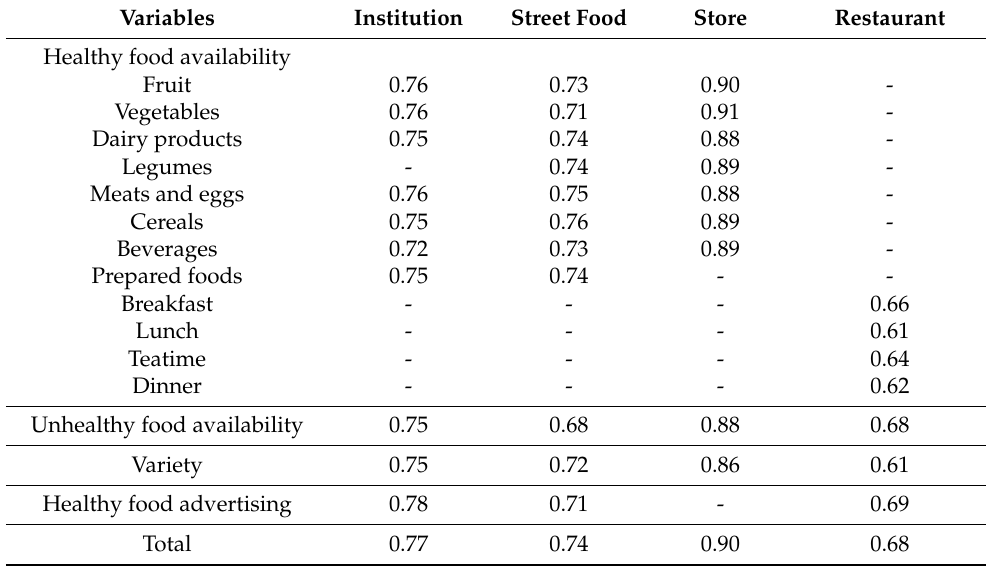
Table 3. Reliability analysis of items for the dimensions of each instrument to measure food environments. Variables